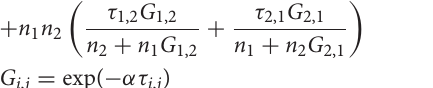
TABLE 3 | Experimental VLE data of the H 2 O(1) + CH 3 OH(2) + KI(3)